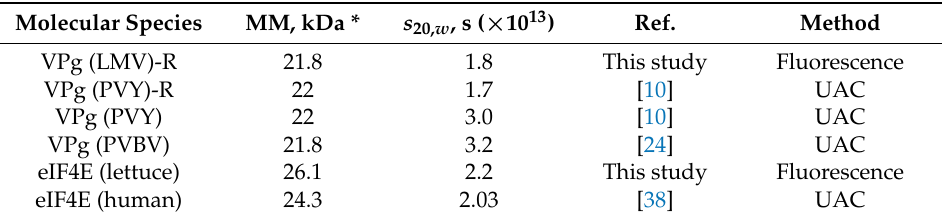
Table 2. VPgs and eIF4E sedimentation coefficients in water at 20 ◦